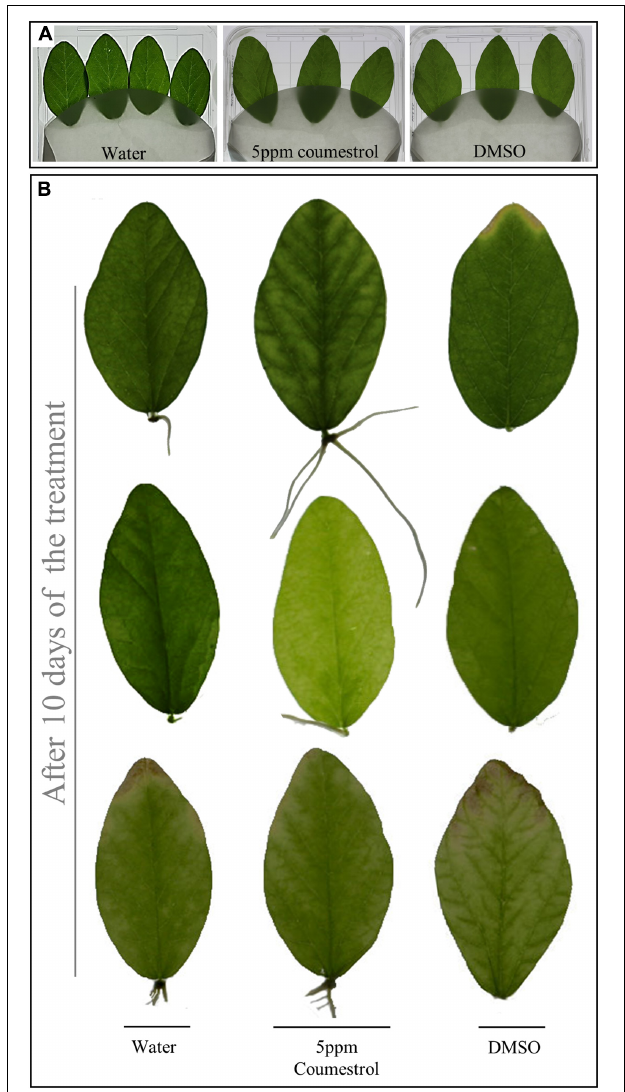
FIGURE 3 | External application of coumestrol to soybean leaves. Leaves from soybean plants were treated with water, an optimized concentration of 5 ppm coumestrol, and dimethyl sulfoxide (DMSO) (A) . Replicated leaf images showing the development of roots after 10 days of the treatment with coumestrol only (B)